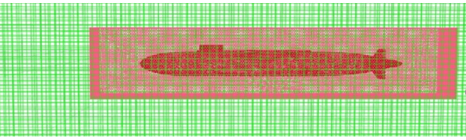
Figure 3. Overlapping grid of underwater vehicle e and sea waters.